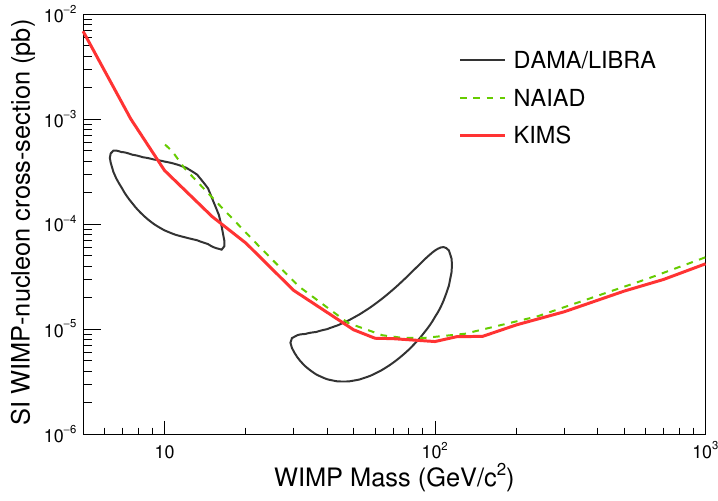
Figure 8 . Observed (red solid line) 90% CL exclusion limits on the WIMP-nucleon spin- independent cross sections. The contour from WIMP-induced DAMA phase-1 3 (cid:27) allowed signal region [11] and the limit from the previous NaI(Tl) detector from the NAIAD experiment [32] are